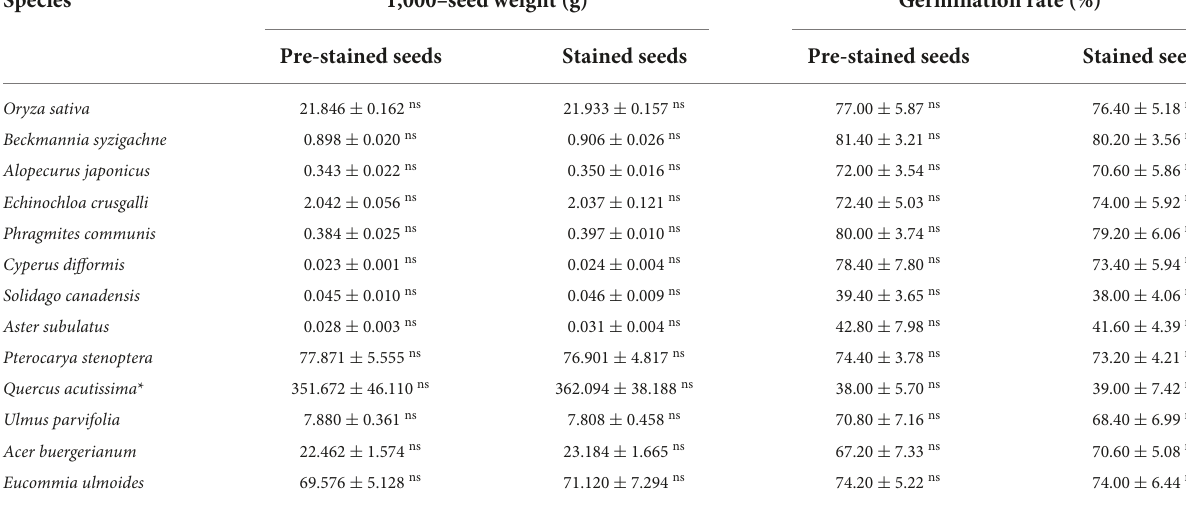
TABLE 3 Influence of staining seeds with safranine on seed weight and